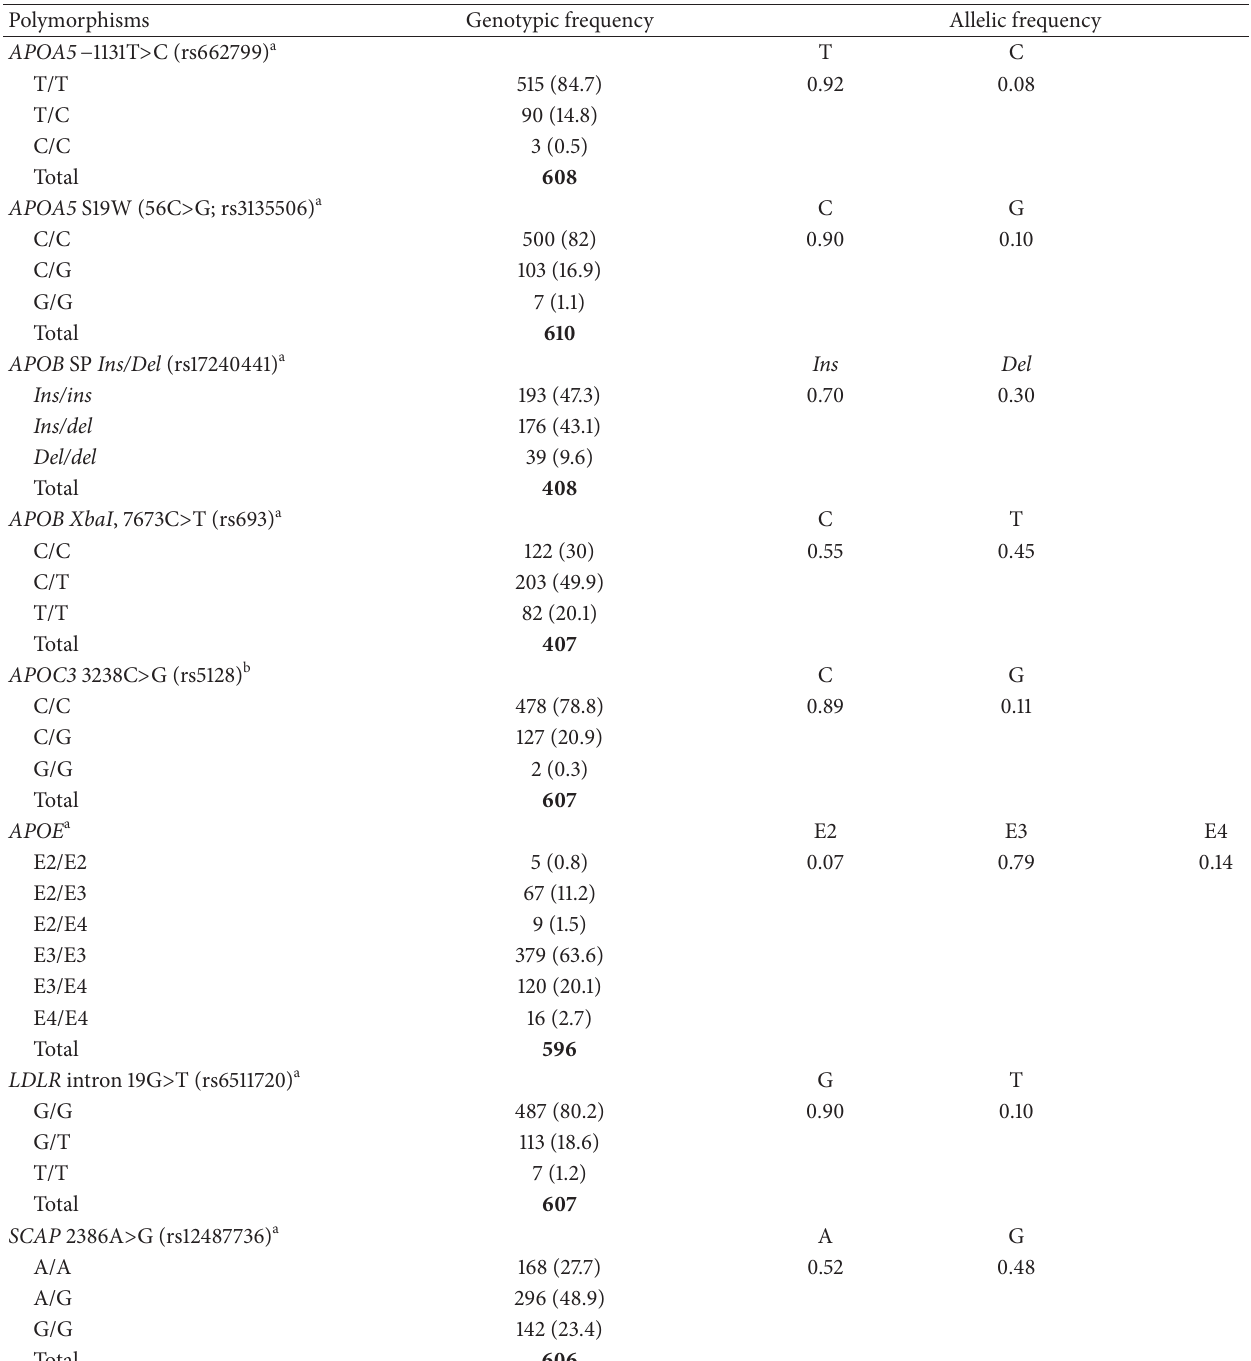
Table 1: Genotypic and allelic frequencies of polymorphisms